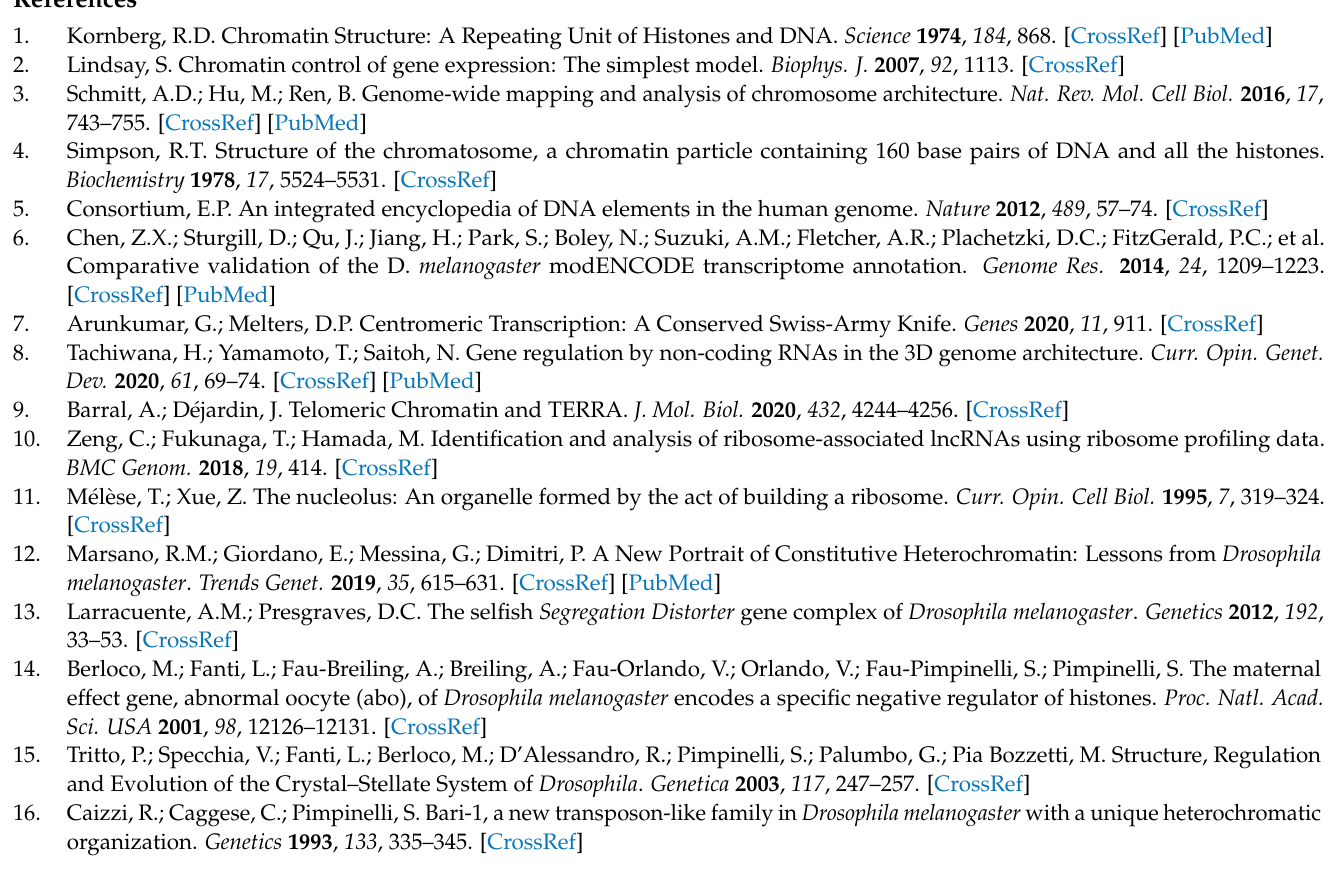
Supplementary Figure S1: In vitro assays (EMSA) suggesting the specificity of the Doc5/Rpl22 binding. Supplementary Figure S2: ( A ). Rpl22 co-localizes with fibrillarin in S2R+ cells. From the left to the right: DAPI, anti-fibrillarin, anti-Rpl22, merged signals. Signal pseudo-coloring in the merged image is as follows. DAPI: blue; Fibrillarin: red; Rpl22: green. The arrowhead in the merged image point to the nucleolus. A magnified detail of the nucleolar co-localization is reported in the inset. ( B ). Rpl22 co-localizes with fibrillarin in polytene nuclei. From the left to the right: DAPI, anti-fibrillarin, anti-Rpl22, merged signals. Signal pseudo-coloring in the merged image is as follows. DAPI: blue; Fibrillarin: green; Rpl22: red. Arrowheads in the merged image point to nucleoli. Table S1. List of the yeast clones tested in the Galactosidase assay. Clones carrying Rpl22 sequences are reported in